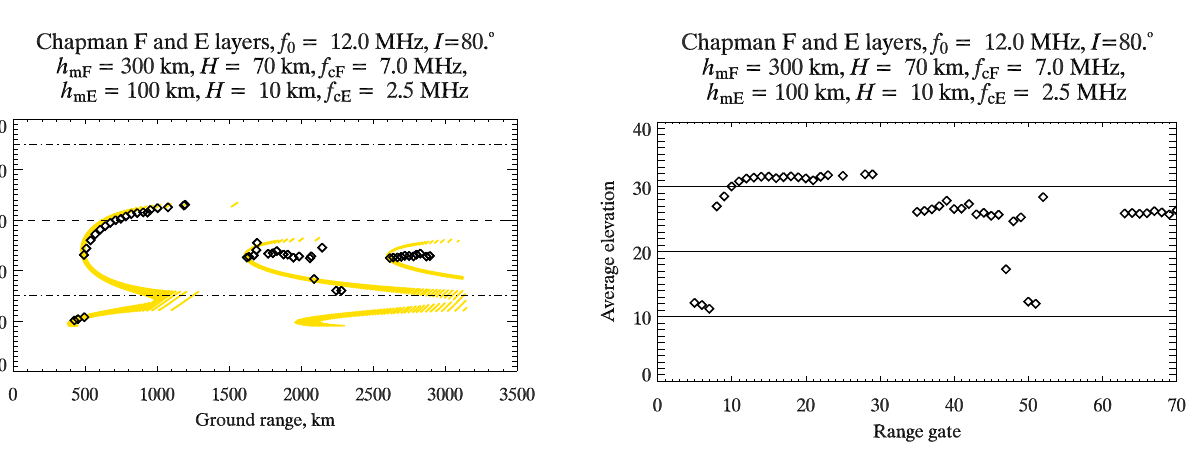
Fig. 8. Effective elevation angle vs. range for the model data shown in Fig.